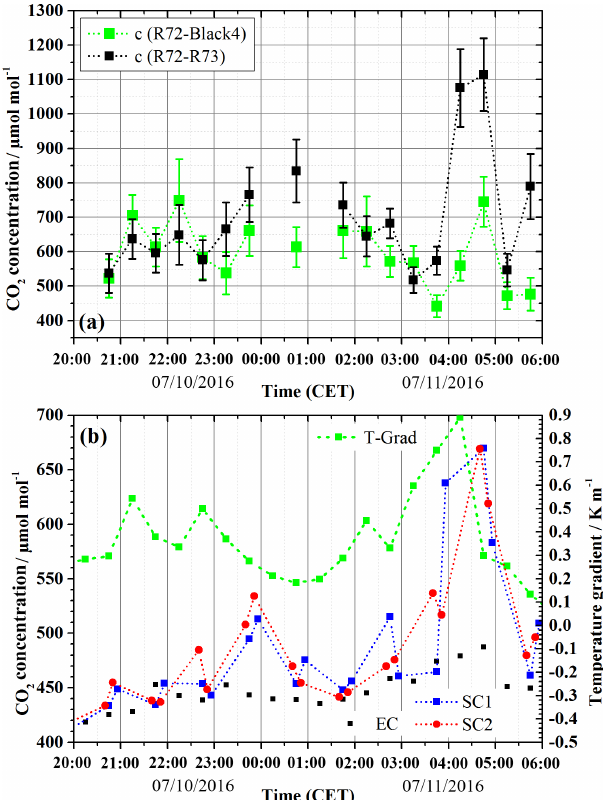
Figure 14. Averaged (30min) CO 2 concentration measured by (a) OP-FTIR at perpendicular paths at a height of about 1.0m above ground, which is representative for total investigation area with ver- tical extent due to field of view, and with maximum uncertainties; (b) EC station at a height of 3.0m by two soil respiration cham- bers at the ground surface (SC1–2: horizontal distance between the chambers 5m); and vertical temperature gradient measured by A- TOM (3.0–1.5m).